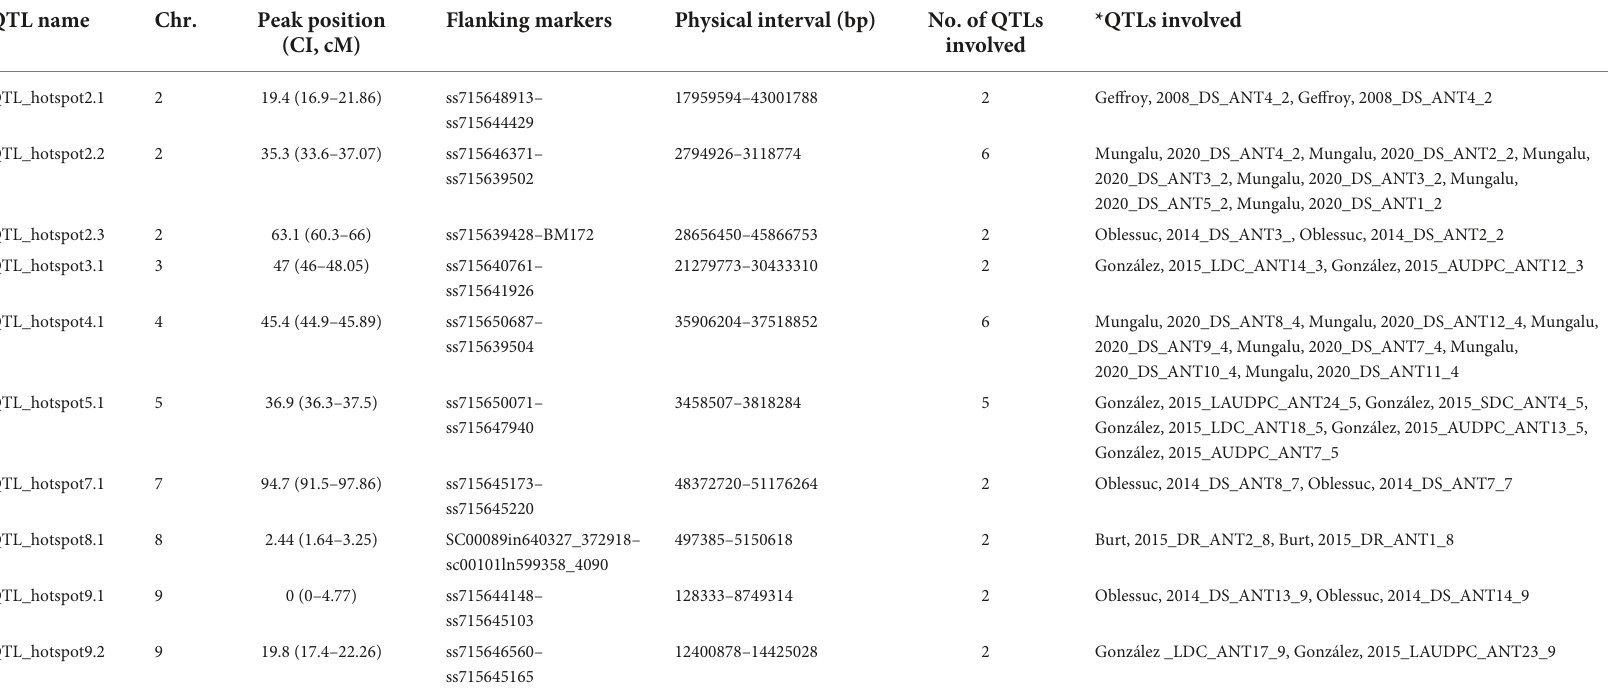
TABLE 3 Details of quantitative trait loci (QTL) hotspots identified for anthracnose disease resistance in common